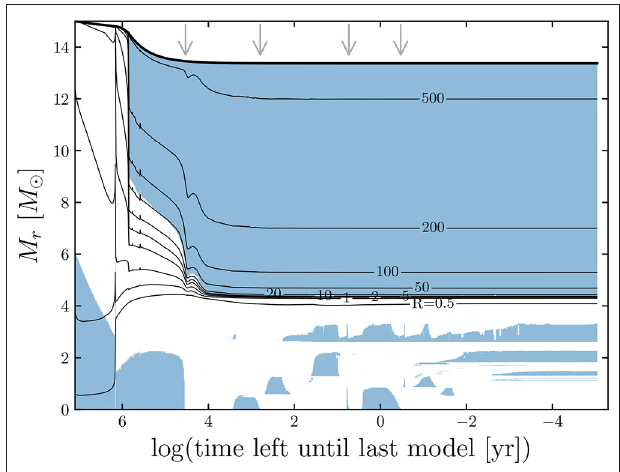
FIGURE 3 | Kippenhahn diagram of a 15 M model at solar metallicity, ⊙ computed until the end of central O burning. The blue shaded regions are convective. Iso-radii are over-plotted (in solar radius units). The gray arrows mark the temporal location of the abundances profiles of Figure 2